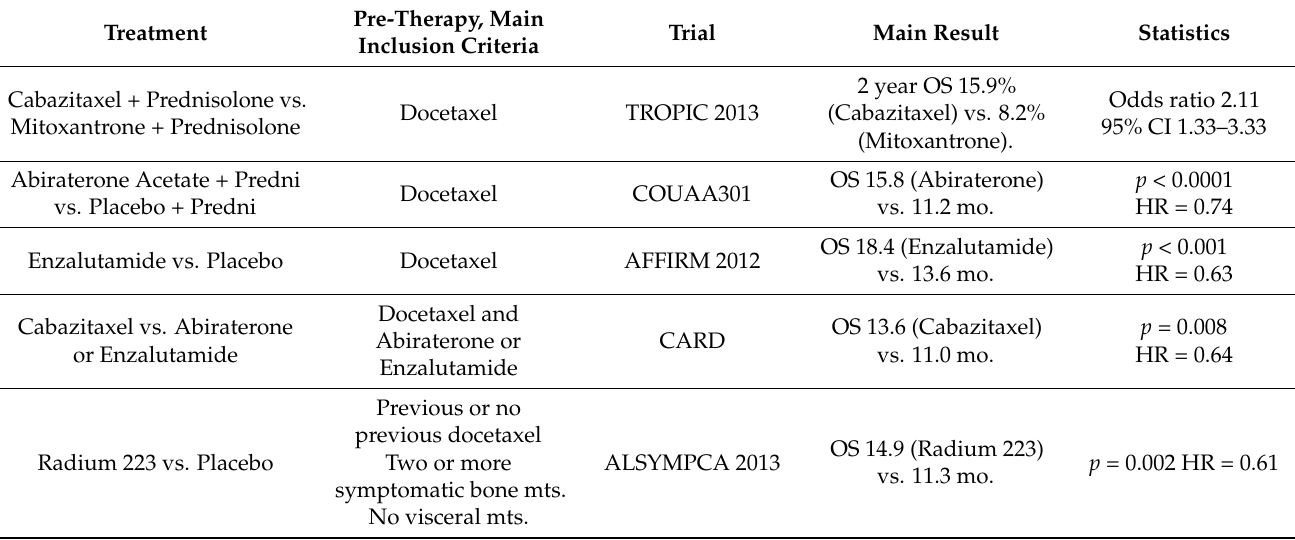
Table 5. Options after pretreatment in